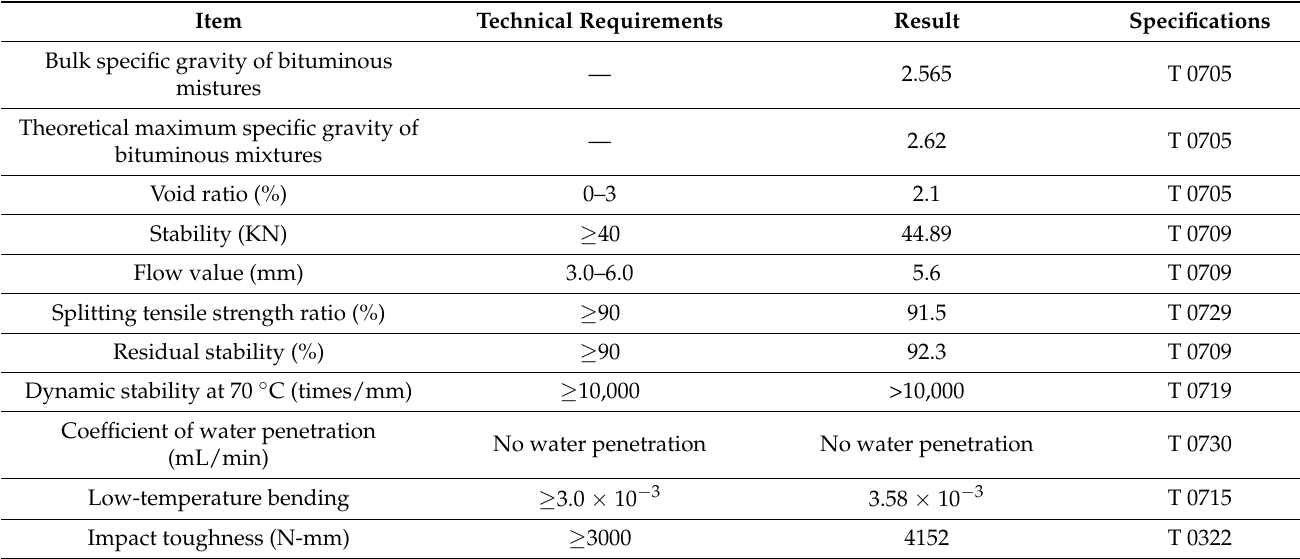
Figure 5. Top pavement FAC-10 grading curve. Table 8. Mix proportion verification.